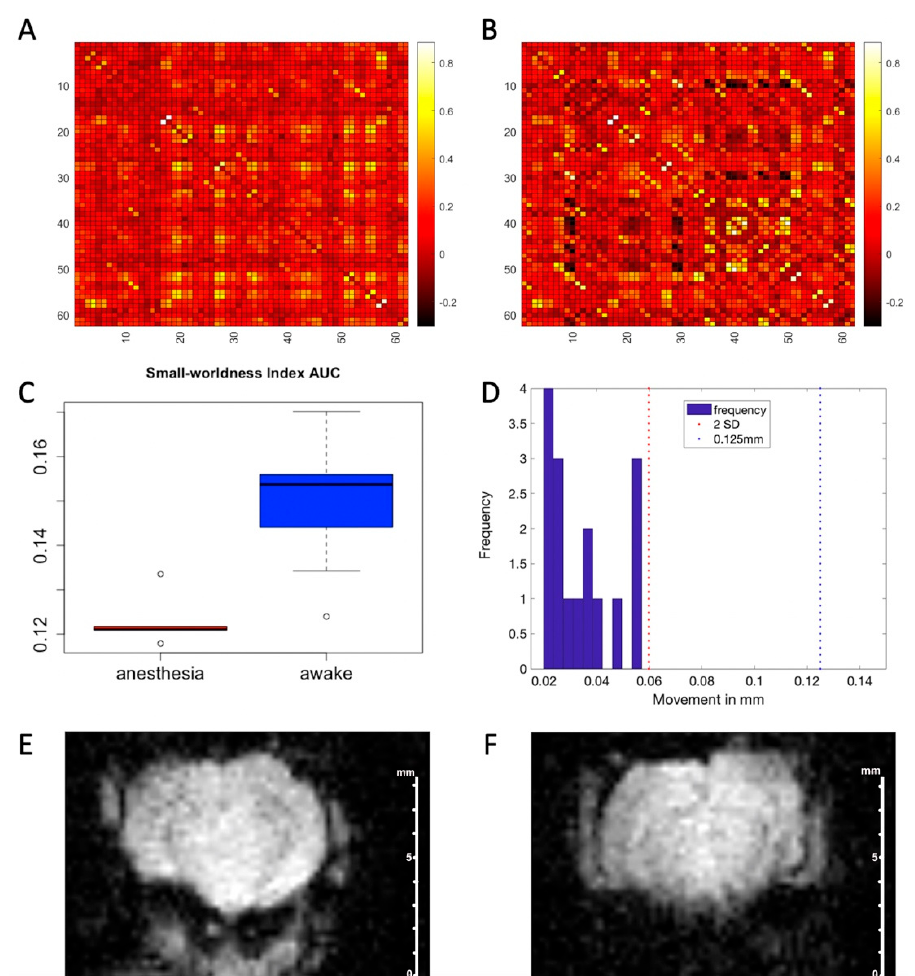
Figure 8. Functional connectivity matrices for anesthetized ( A ) and awake ( B ) mice were highly similar via Mantel test (r = 0.61, p < 0.001). See Supplemental Table S1 for brain regions indicated on X and Y axes. Small-worldness index area under the curve ( C ) was significantly higher in the awake group (W = 1, p < 0.001). Movement, as measured by root mean squared framewise displacement ( D ), was below the half in-plane voxel (0.125 mm) and 2 standard deviation (SD) cutoffs for all mice. Motion did not differ significantly between groups (W = 25, p = 0.83). EPI scans are shown for an anesthetized mouse ( E ) and an awake mouse ( F ).